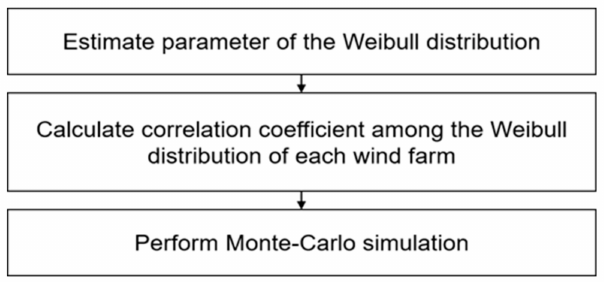
Figure 4. Process of probabilistic wind power output